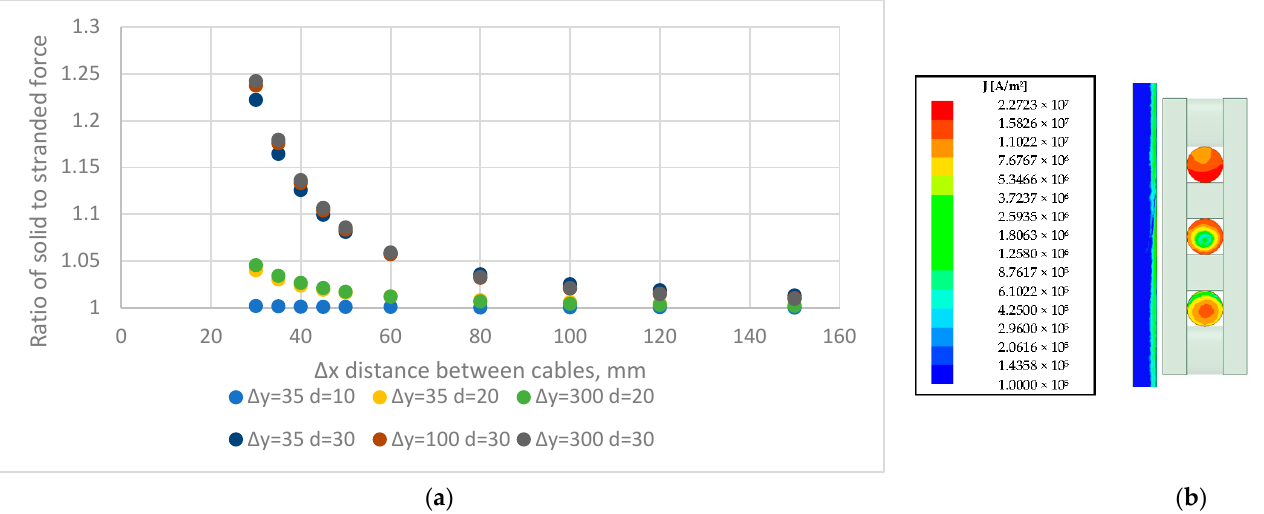
Figure 7. ( a ) Ratio of AC force acting on a solid conductor to force acting on stranded one for upper cable; ( b ) proximity effect for current density distribution.